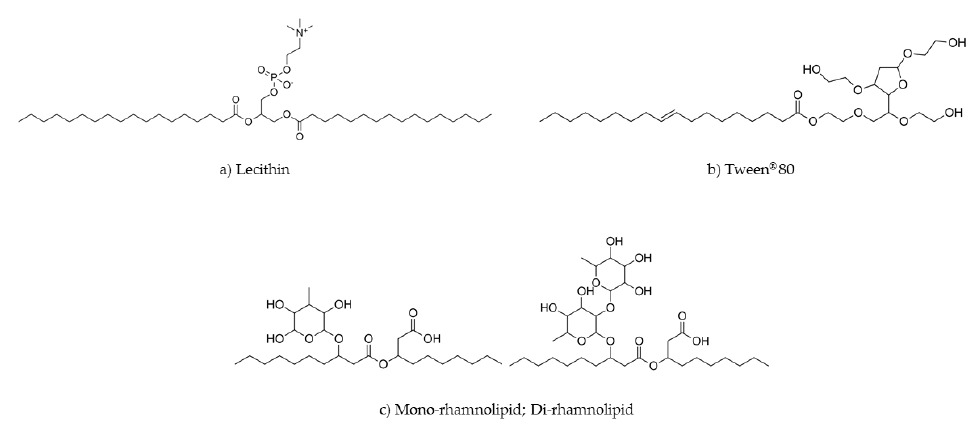
Figure 1. Chemical structure of the different surfactants used: ( a ) lecithin (LEC); ( b ) Tween ® 80 (TWE), and ( c ) two of most common rhamnolipids available (RHAMs).